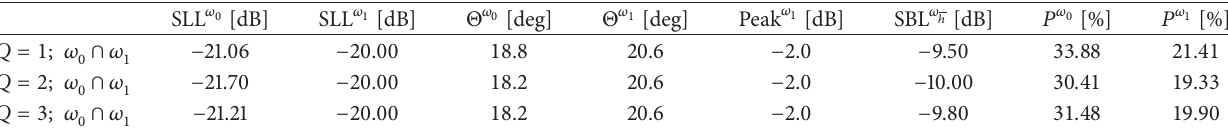
Table 1: Multibeam sum pattern synthesis at 𝜔 0 and 𝜔 1 ( 𝑁 = 16 ; 𝑑 = 𝜆/2 ; 𝜃 𝜔 0 = 90 ∘ ; 𝜃 𝜔 1 = 120 ∘ ) and pattern features for 𝑄 = 1 , 𝑄 = 2 , and 𝑄 = 3 .